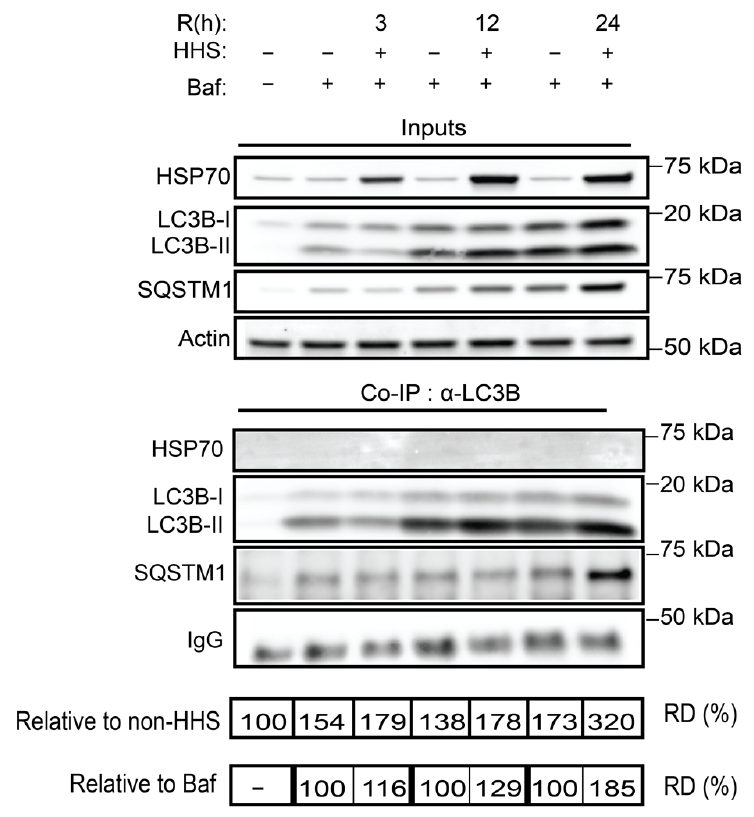
Figure 5. LC3B associated interactome in the presence of HHS. ARPE-19 cells were exposed initially for 6 h to 50 nM Bafilomycin (Baf); then, cells were treated without HHS (–) or with 30 min HHS (+) at 42 °C, followed by recovery at 37 °C in the presence of Baf. Immunoprecipitation of the LC3B was performed with LC3B antibody to identify interactions between LC3B/HPS70 and LC3B/SQSTM1 complex. The protein complex formation was normalized to the IgG as loading control. R shows the post-HHS time of recovery at 37 °C. The complex interaction status was determined by relative densitometry (RD) in percentage compared to either Non-HHS/Non-Baf or Non-HHS/Baf. The immunoprecipitation was performed from a pool of six independent experiments.